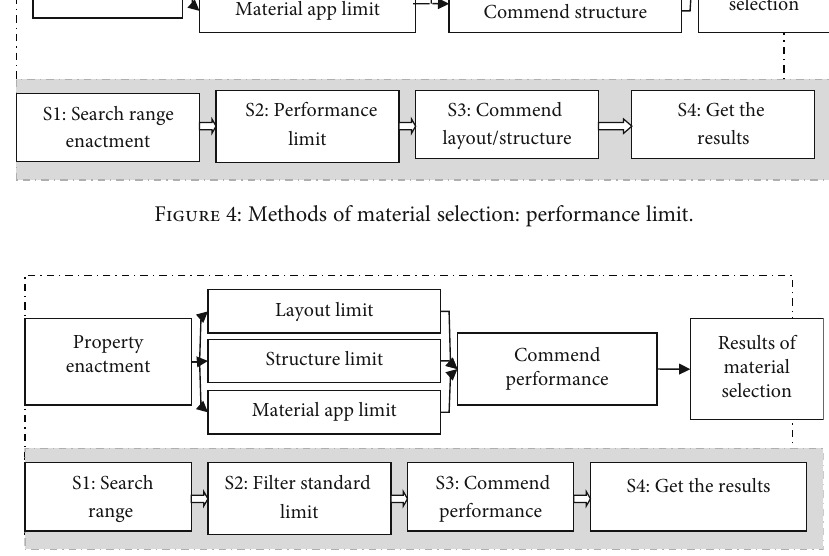
Figure 5: Methods of material selection: layout